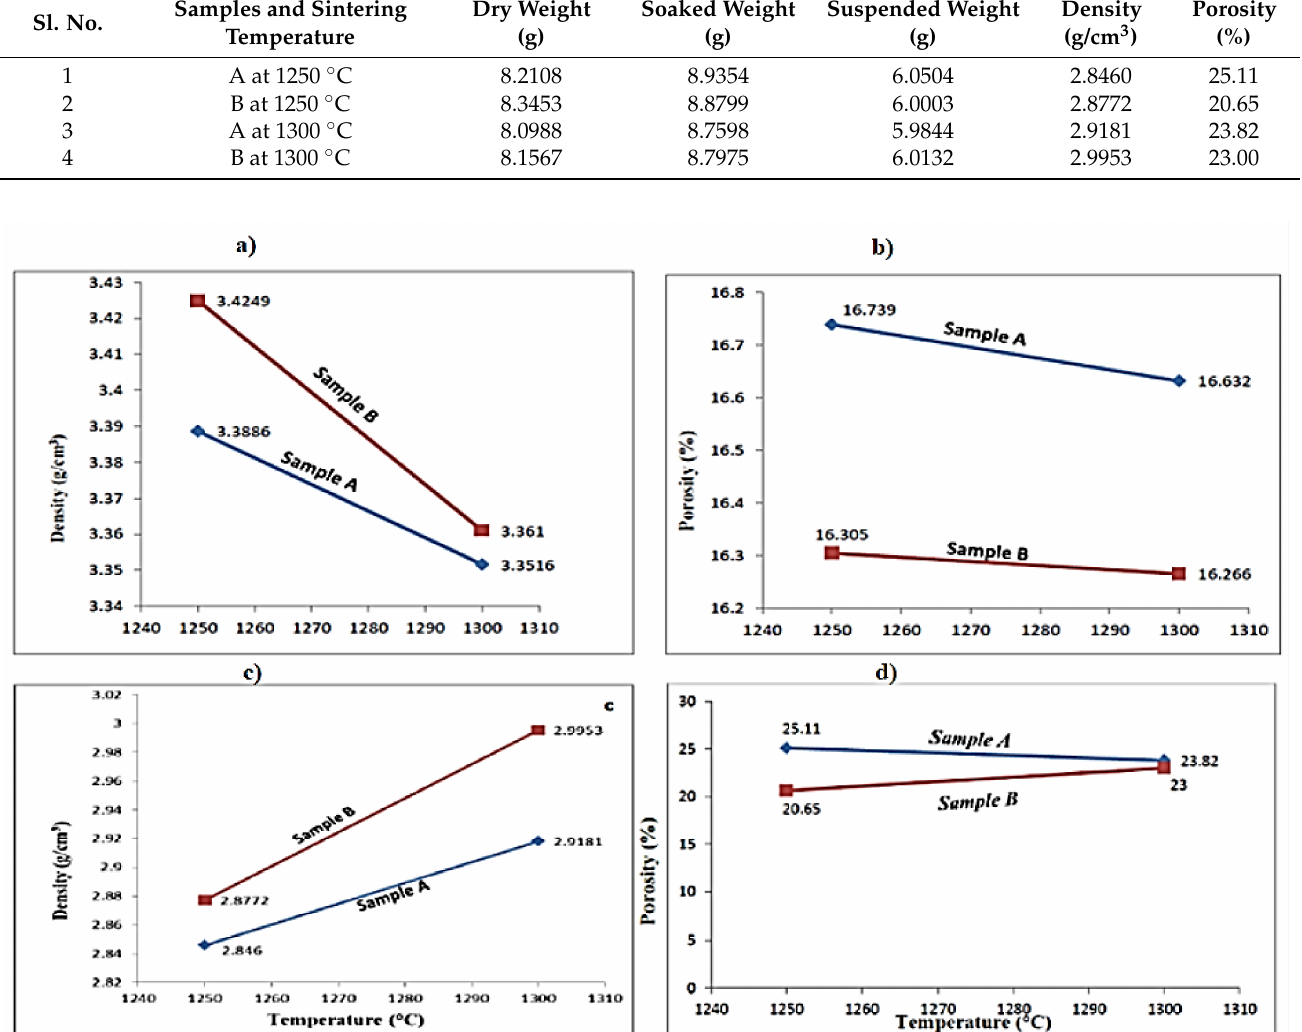
Table 3. Density and porosity measurement of conventionally sintered samples.